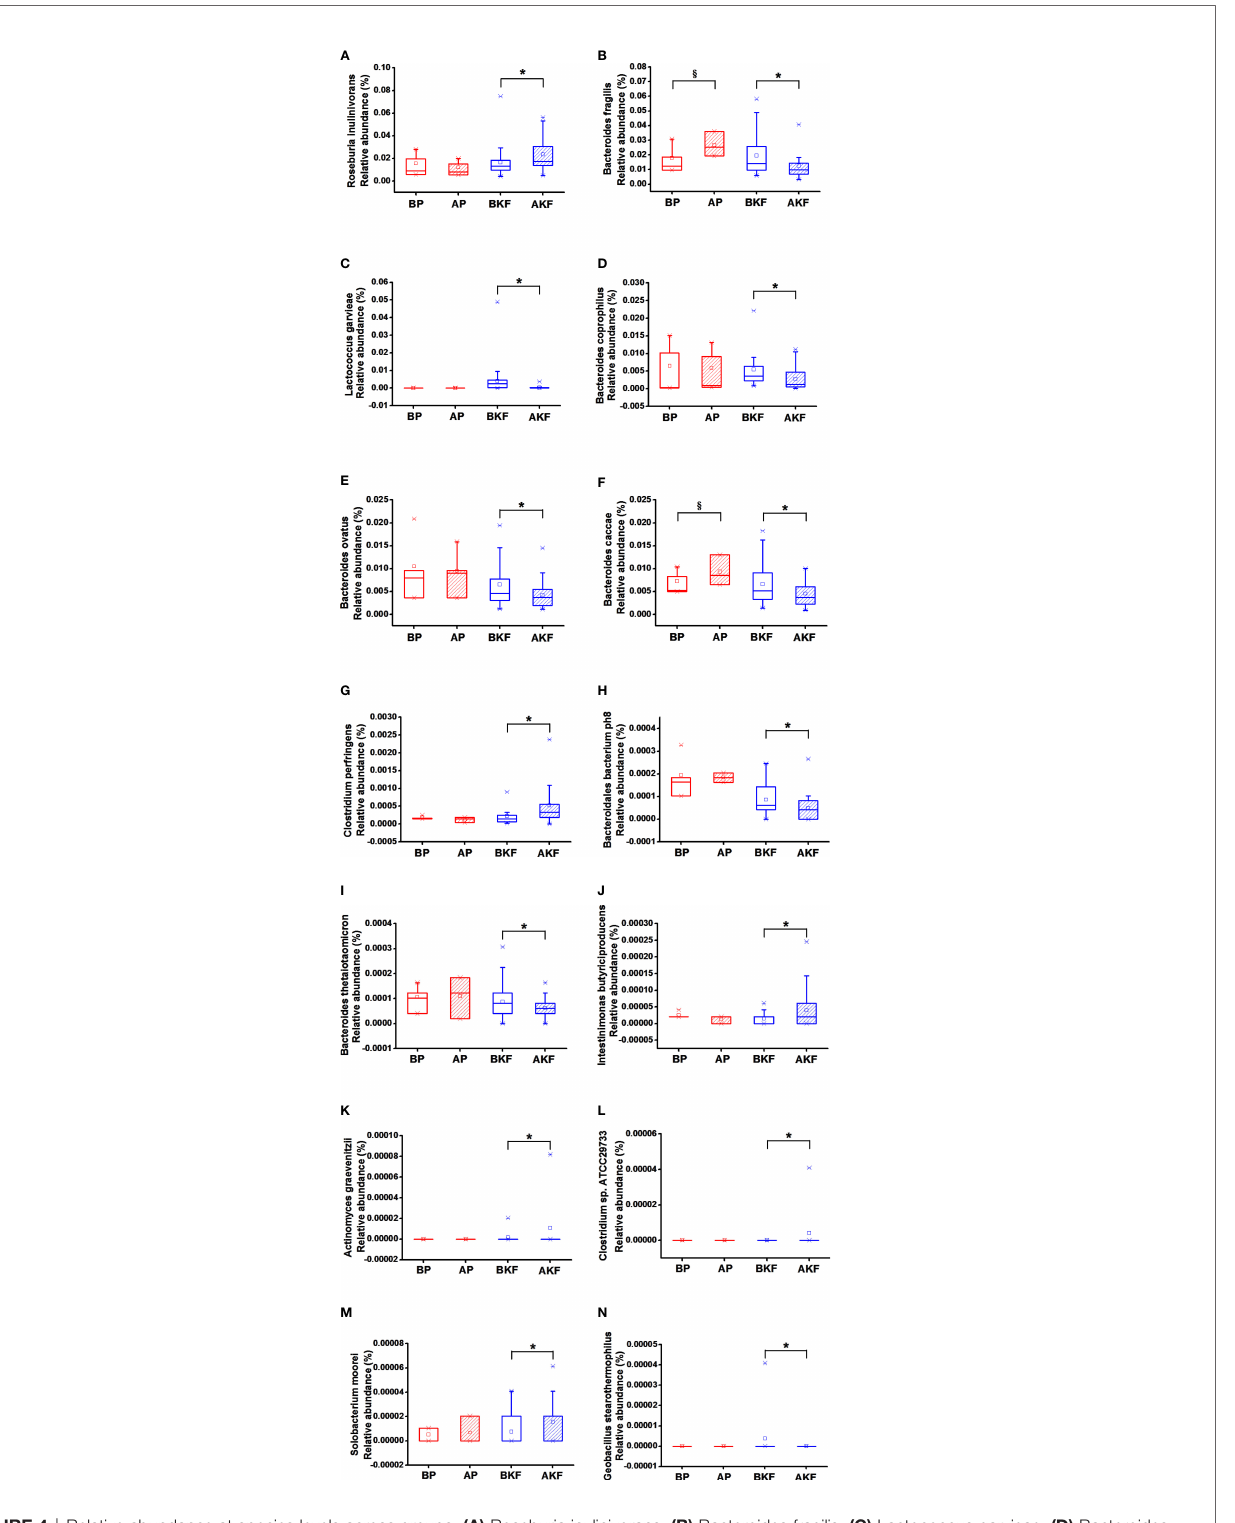
FIGURE 4 | Relative abundance at species levels across groups. (A) Roseburia inulinivorans, (B) Bacteroides fragilis, (C) Lactococcus garvieae, (D) Bacteroides coprophilus, (E) Bacteroides ovatus, (F) Bacteroides caccae, (G) Clostridium perfringens, (H) Bacteroidales bacterium ph8, (I) Bacteroides thetaiotaomicron, (J) Intestinimonas butyriciproducens, (K) Actinomyces graevenitzii, (L) Clostridium sp. ATCC 29733, (M) Solobacterium moorei, (N) Geobacillus stearothermophilus. § p < 0.05 versus BP and *p <0.05, versus